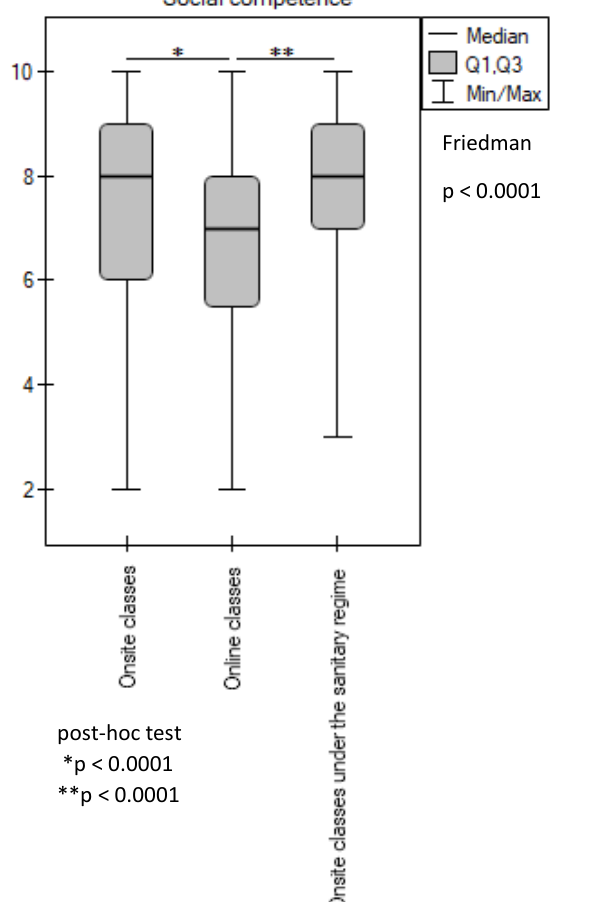
Figure 4. Evaluation of the learning outcomes in social competence. *, ** p -value is given for statistically significantly different groups. For groups with no significant differences ( p ≥ 0.05), the p -values are not quoted.